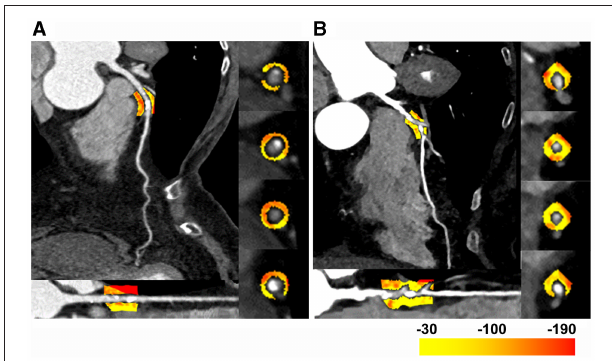
FIGURE 4 | Two representative cases of the FAI difference in lesions with or without abnormal fractional flow reserve (FFR). (A) The left anterior descending (LAD) artery of a 60–65 years old patient. The FAI lesion was − 92 HU, and the FFR was 0.88 with a 70% lumen stenosis. (B) The LAD of a 70–75 years old patient. The FAI lesion was − 77 HU, and the FFR was 0.6 with a 78% lumen stenosis. FAI lesion , lesion-specific fat attenuation index; LAD, left anterior descending; FFR, fractional flow reserve; HU, Hounsfield unit.